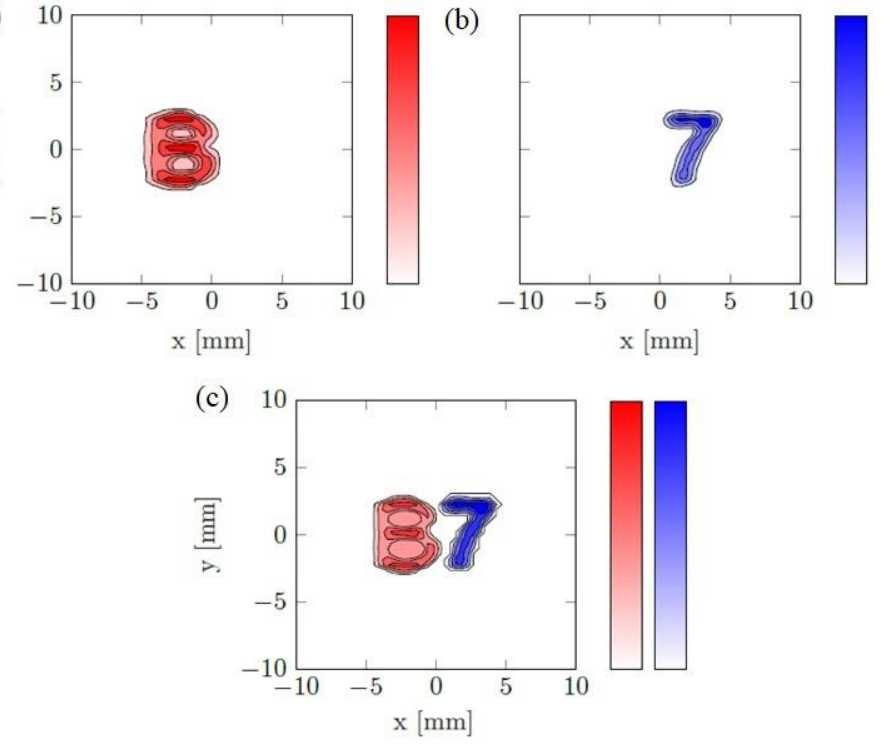
Figure 3. The simulation results for the reconstruction of two different MNP types; ( a ) Red and ( b ) blue color indicate MNP type I and II; ( c ) Combined reconstructed image. The color bar indicates the particle amount.